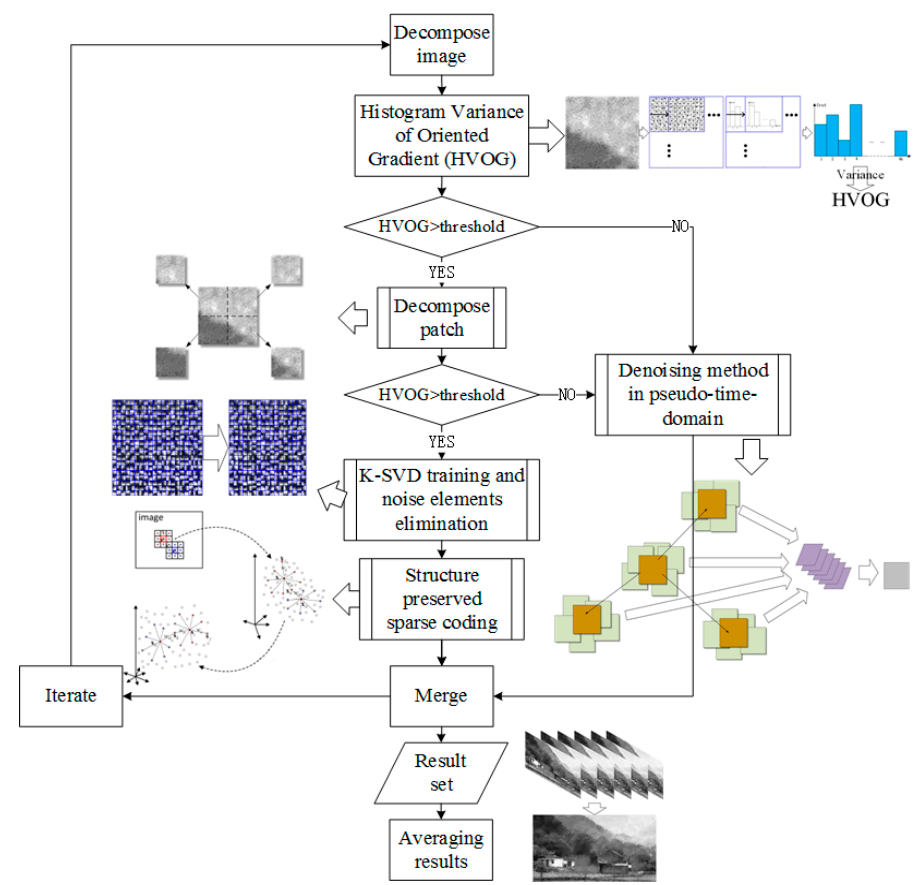
Figure 2. The framework of the denoising scheme for ICCD sensing image.